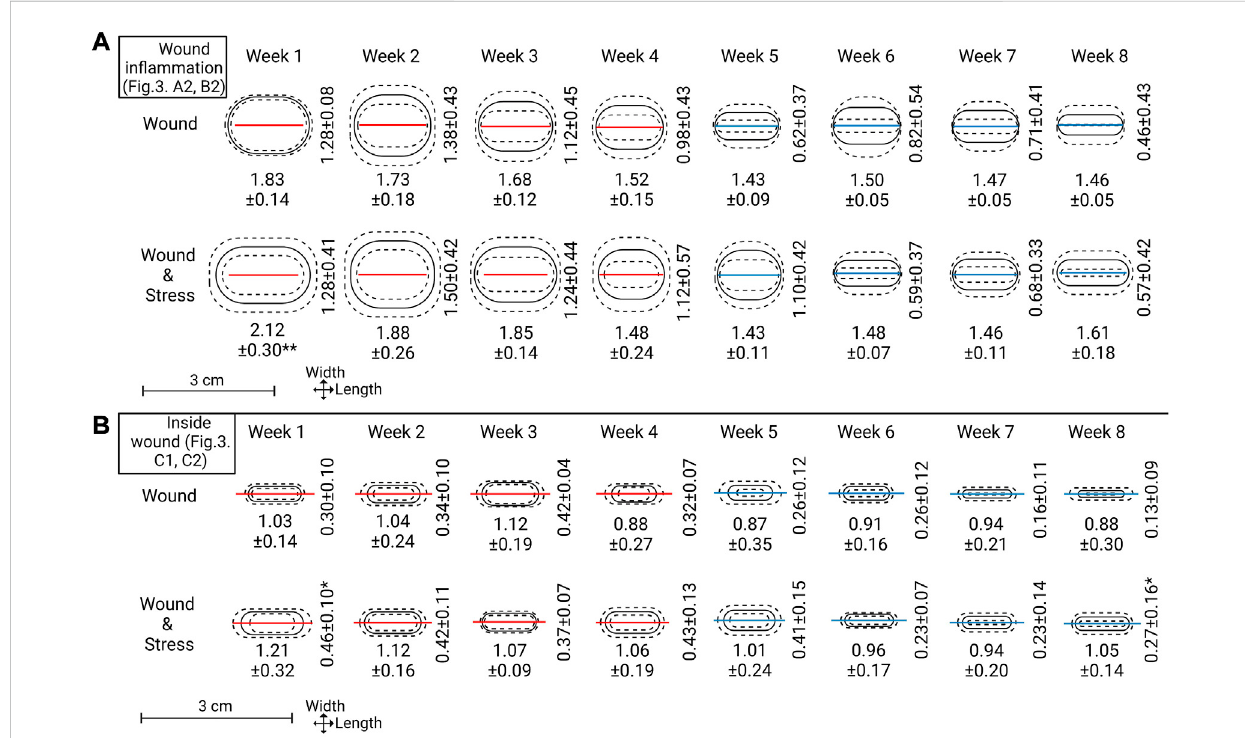
FIGURE 5 Top section (A) : Wound in fl ammation width and length measurements for each week are represented as means (solid line) ± standard deviation (dashed lines). The red or blue line within the ovals represents the mean length of incision (A1 in Figure 3). A red line indicates not all replicates within that week had wound width (B1 in Figure 3) = 0.0 cm and a blue line indicate all replicates within that week had wound width = 0.0 cm. Lower sections (B) : Inside wound healing width and length, represented the same as the top section. Mean incision length lines are carried over to represent scale and show a comparison point to the outside wound (note: section (B) is slightly zoomed see the length of scale). Signi fi cance between groups for length or width is represented as * = p ≤